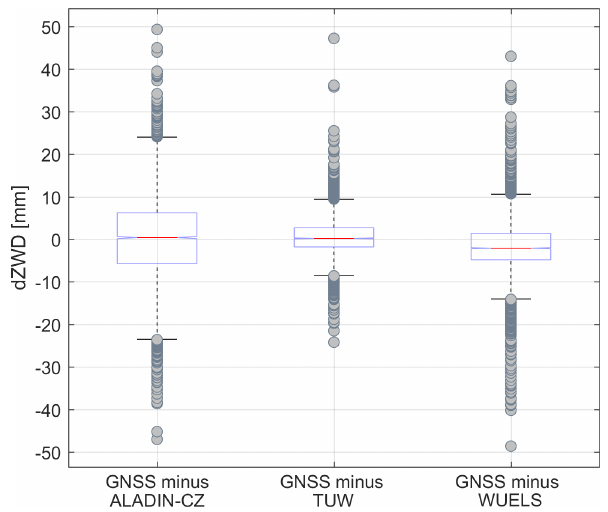
Figure 7. Box plots of the ZWD differences for ALADIN-CZ, TUW and WUELS models, compared to the GNSS data for all 88